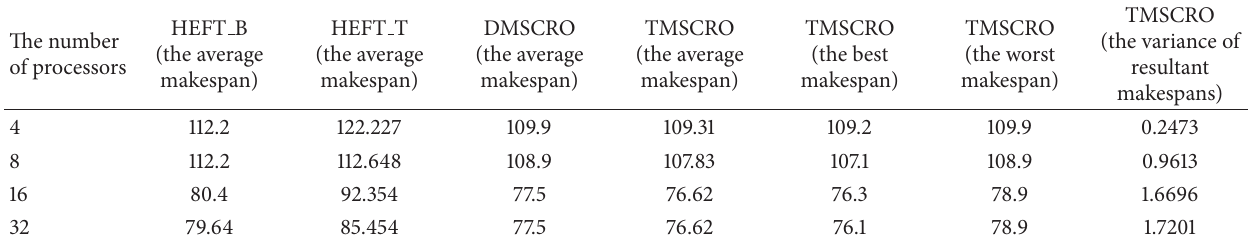
Table 6: The experiment results for the Gaussian elimination graph under different CCRs; the number of processors is 8.